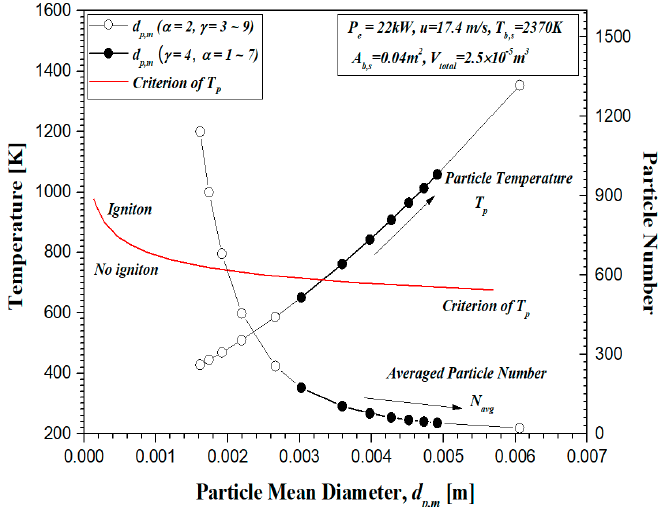
Figure 11. The effects of particle temperature, particle number, and the critical on the particle mean diameter (for ignition of flammable materials).